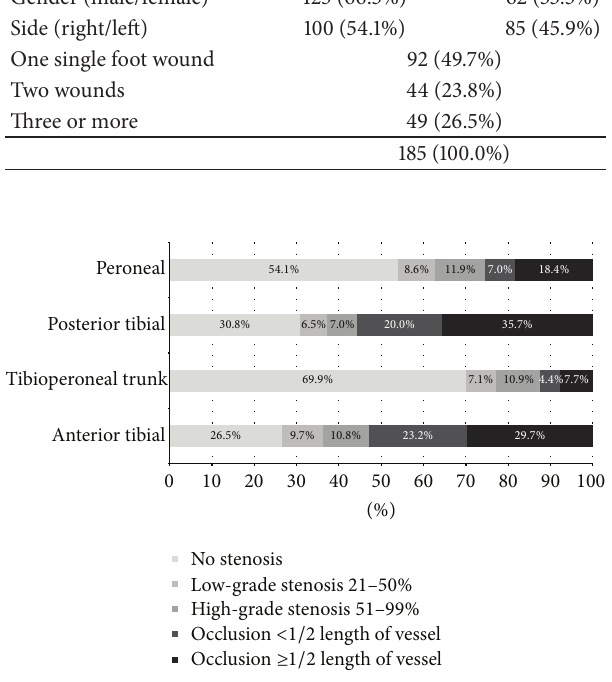
Figure 2: Distribution of atherosclerotic lesions on angiography ( 𝑛 = 185